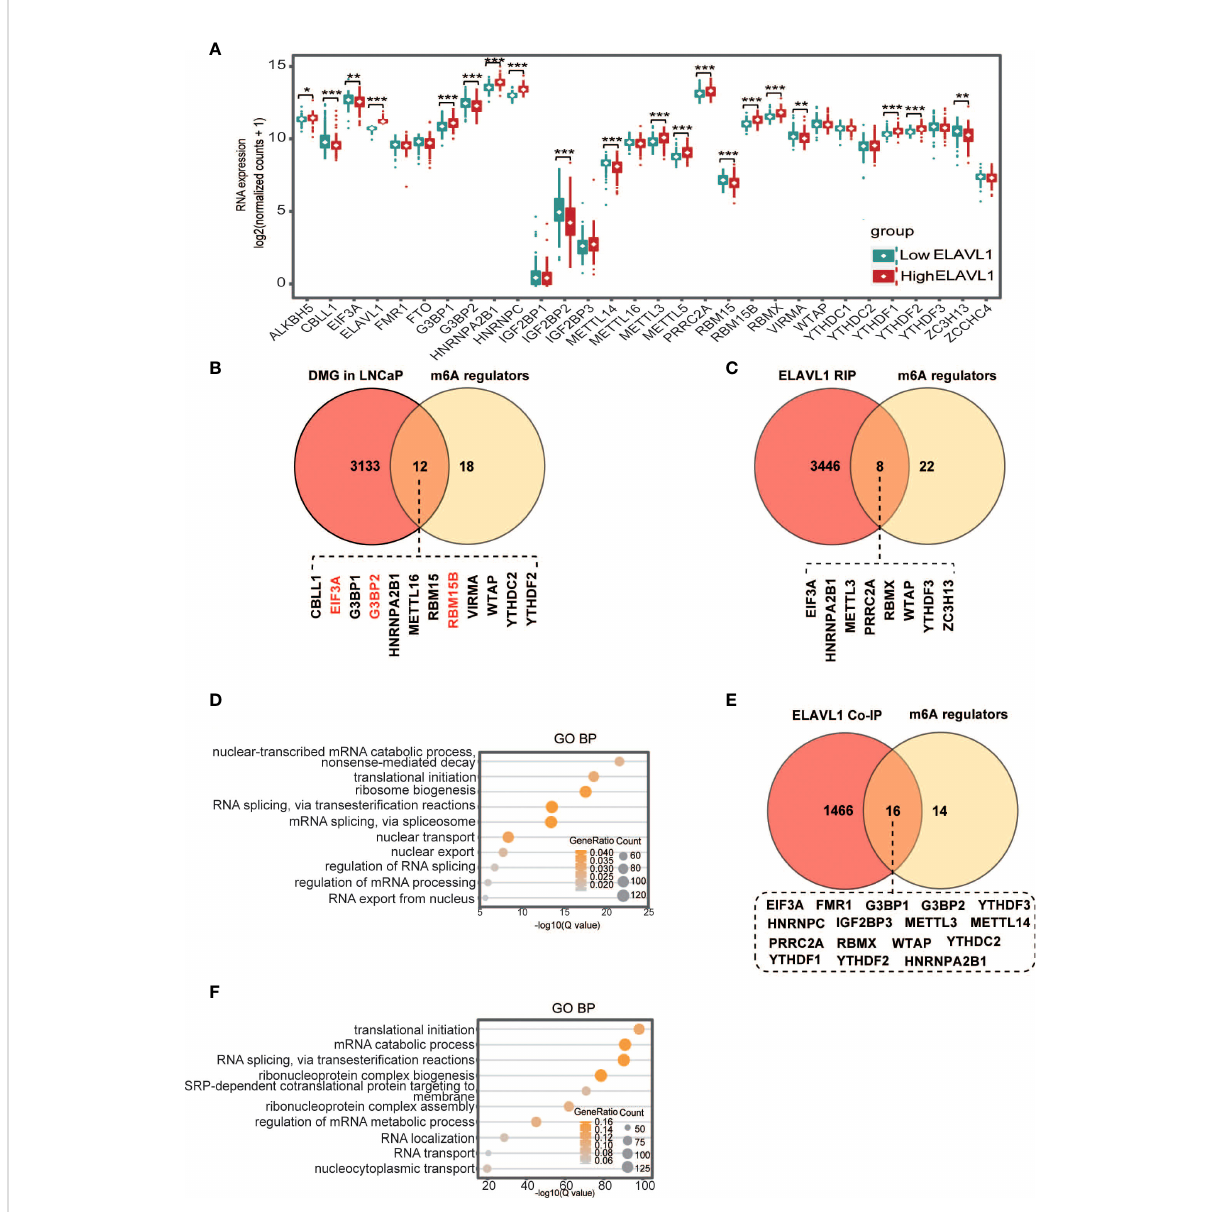
FIGURE 5 Interactions between ELAVL1 and other m6A regulators. (A) Differentiated expression of m6A regulators between the low- and high-ELAVL1 groups; (B) Venn diagram for differentially expressed m6A genes in LNCaP cells and m6A regulators; (C) Venn diagram for ELAVL1 RIP and m6A regulators; (D) GO analysis for ELAVL1 RIP; (E) Venn diagram for ELAVL1 co-IP and m6A regulators; (F) GO analysis for ELAVL1 co-IP. *p < 0.05, **p < 0.01, ***p <